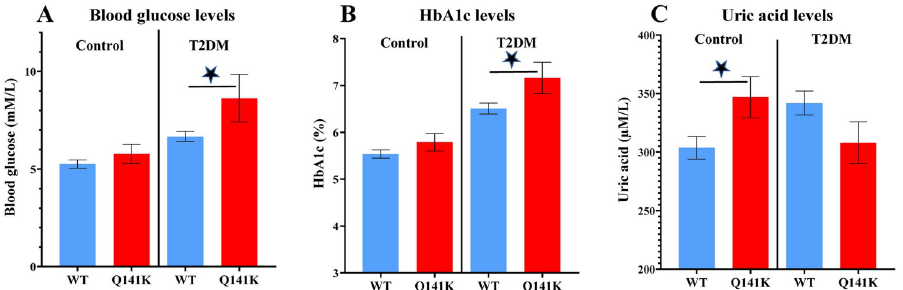
Fig 1. Blood glucose (Panel A), HbA1c (Panel B) or uric acid (Panel C) levels and the presence of the Q141K variant (both hetero- and homozygotes) in the groups of healthy individuals and T2DM patients. Values are expressed as means ± SE. Blue: ABCG2-wild type, red: ABCG2-Q141K. Star ( � ) indicates a significant difference obtained in the individuals carrying the Q141K polymorphism � p < 0.05. The p values were calculated by Student’s t- test.